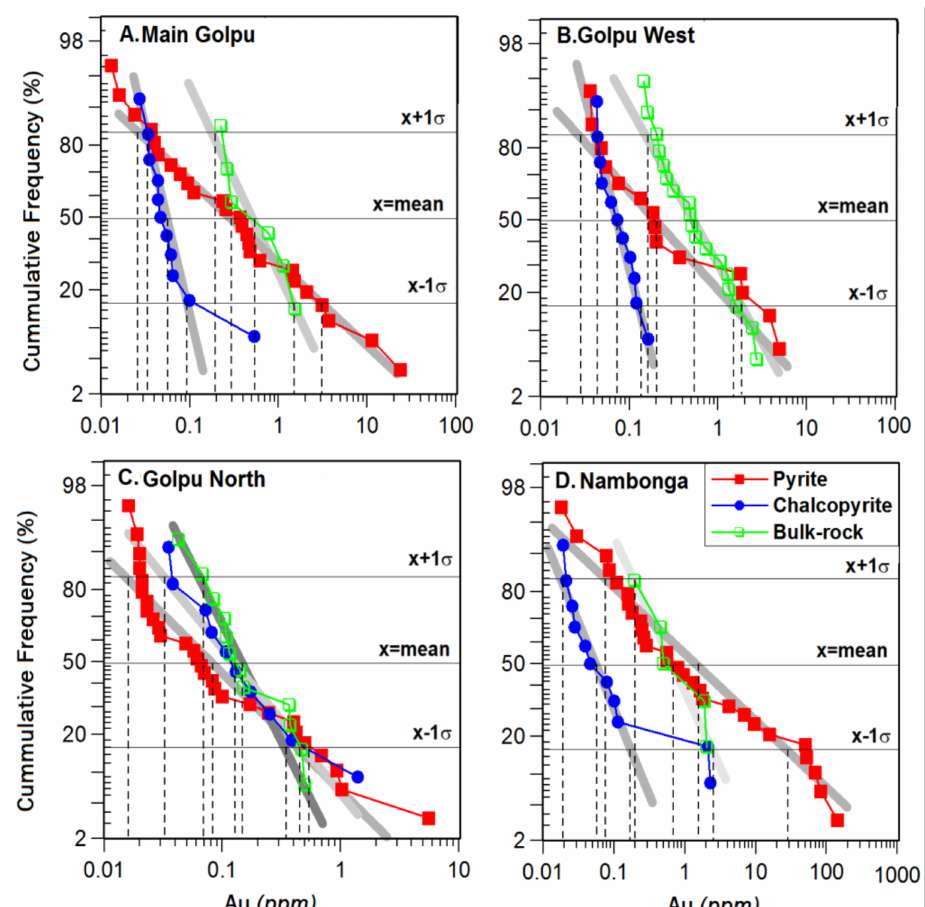
Figure 7. Cumulative frequency graphs of LA-ICPMS Au measurements in pyrite, chalcopyrite and bulk-rock, ( A ) Main Golpu porphyry; ( B ) Golpu West porphyry; ( C ) Golpu North porphyry; and ( D ) Nambonga North